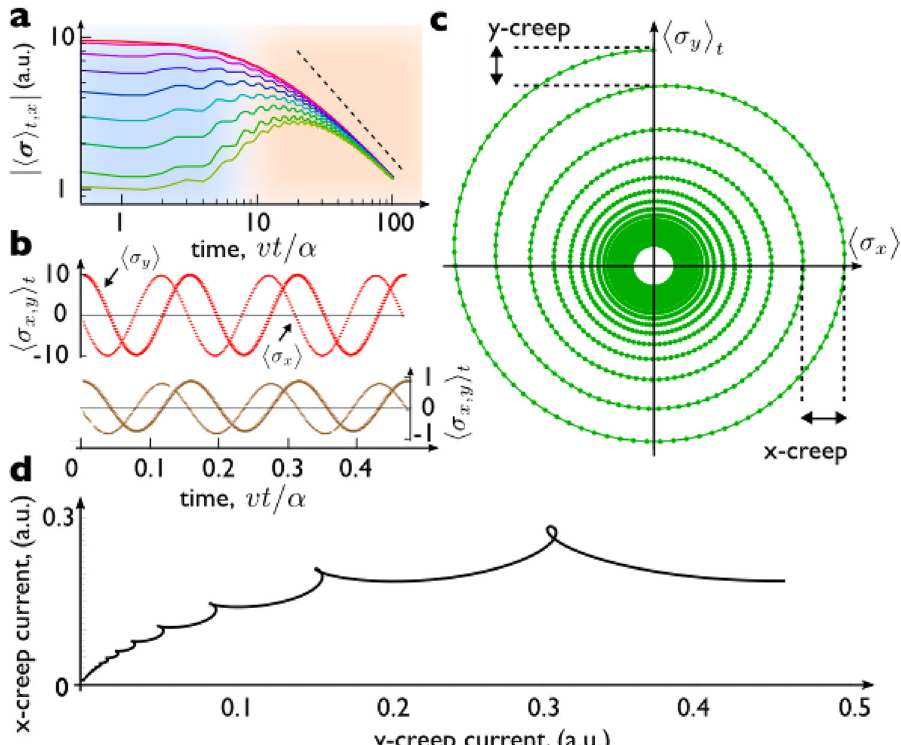
Fig. 3 Evolution of pseudospin expectation and its creep after the quench. a Log – log plot of dynamical evolution of the local pseudospin magnitude ∣ 〈 σ 〉 t , x ∣ for large dimensionless mass m α /( _ v ) = 20. It exhibits a frozen (blue) and a melting regime (orange); dashed line indicates a t − 1 temporal power-law decay. The curves from top to bottom (red to green) indicate various positions away from the domain wall x / α = 0 → 1.2 in steps of 0.15. b σ x oscillation at x = 0 (red) and x / α = 1.2 (brown). c Trajectory of 〈 σ 〉 t , x for x = 0 for m α /( _ v ) = π exhibiting a decay in the pseudospin density over time. d The decay over each cycle leads to a creep current: a non-vanishing drift current of the topological boundary mode. Creep current estimated by averaging h σ i over a period twice, such as to smooth out fl uctuations in the period. The small kinks represent subleading second-order corrections in the power- x ; y t ; x law